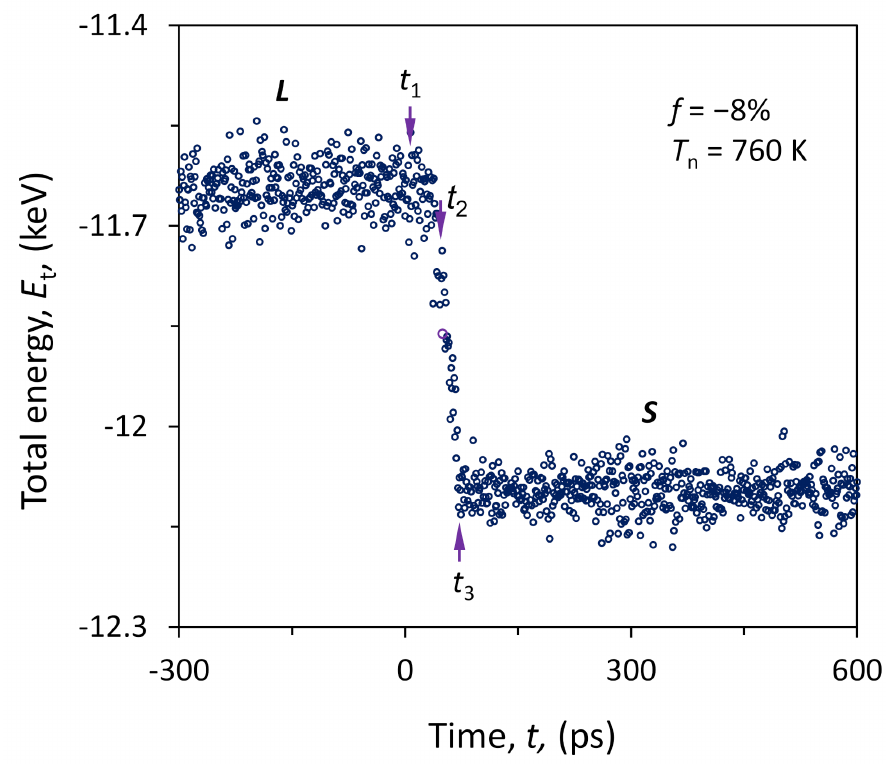
Figure 29. Total energy change in the simulation system during the nucleation [11]. Evolution of total energy ( E t ) of the system with − 8% misfit is plotted as a function of t during the simulation at T n = 760 K. t 1 marks the onset of nucleation, t 2 the end of nucleation and t 3 the end of solidification. L and S denote the liquid and the solid phases,